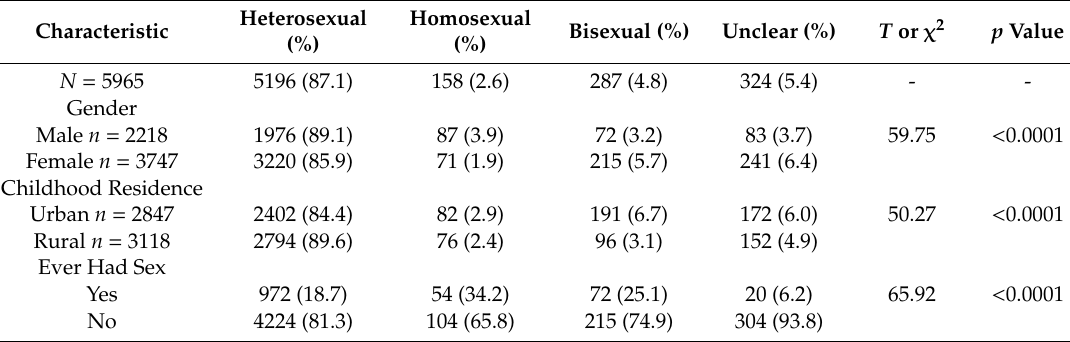
Table 2. Respondents by sexual